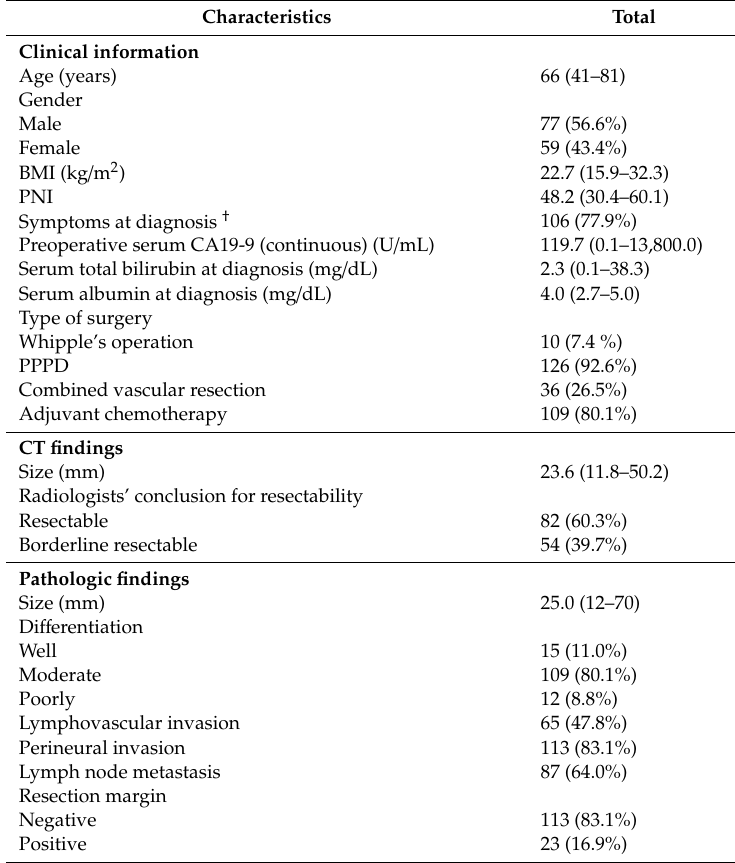
Table 1. Baseline characteristics of the 136 included